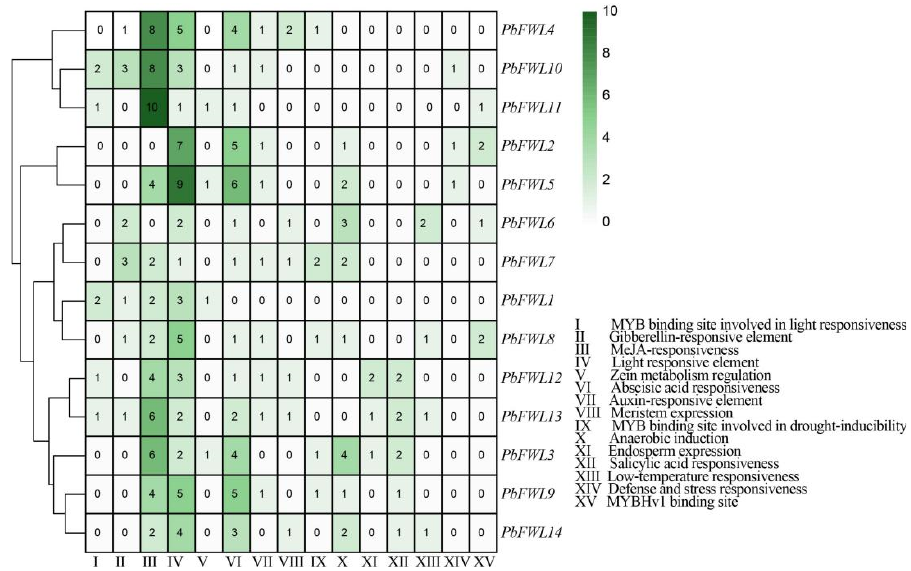
Figure 5. Predicted cis-elements in the promoter of the PbFWL genes. The color scale at the top right indicates the number of cis-acting elements. Green color indicates the number of cis-acting elements on fw2.2-like member. There were a total of 15 cis-acting elements, including (I) MYB binding site involved in light responsiveness; (II) Gibberellin-responsive element; (III) MeJA responsiveness; (IV) light-responsive element; (V) Zein metabolism regulation; (VI) abscisic acid responsiveness; (VII) auxin-responsive element; (VIII) Meristem expression; (IX) MYB binding site involved in drought inducibility; (X) anaerobic induction; (XI) endosperm expression; (XII) salicylic acid responsiveness; (XIII) low-temperature responsiveness; (XIV) defense and stress responsiveness; and (XV) MYBHv1 binding